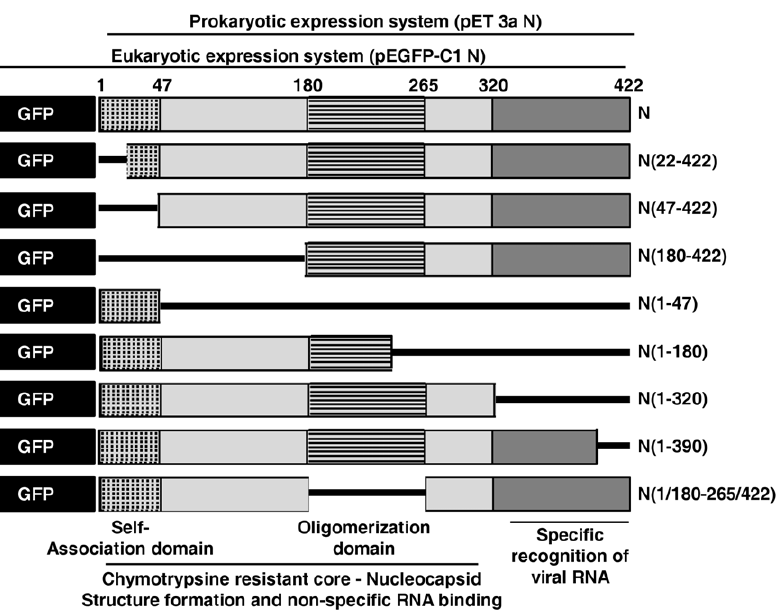
Figure 4. Schematic representation of the wild-type N protein and the mutant N proteins used in this study. Prokaryotic clones were made in pET3a vector for bacterial expression. Eukaryotic clones were made in pEGFP-C1 vector as N terminally GFP fused proteins. Different functionally relevant domains are also shown [21]. The numbers represents amino acid positions.